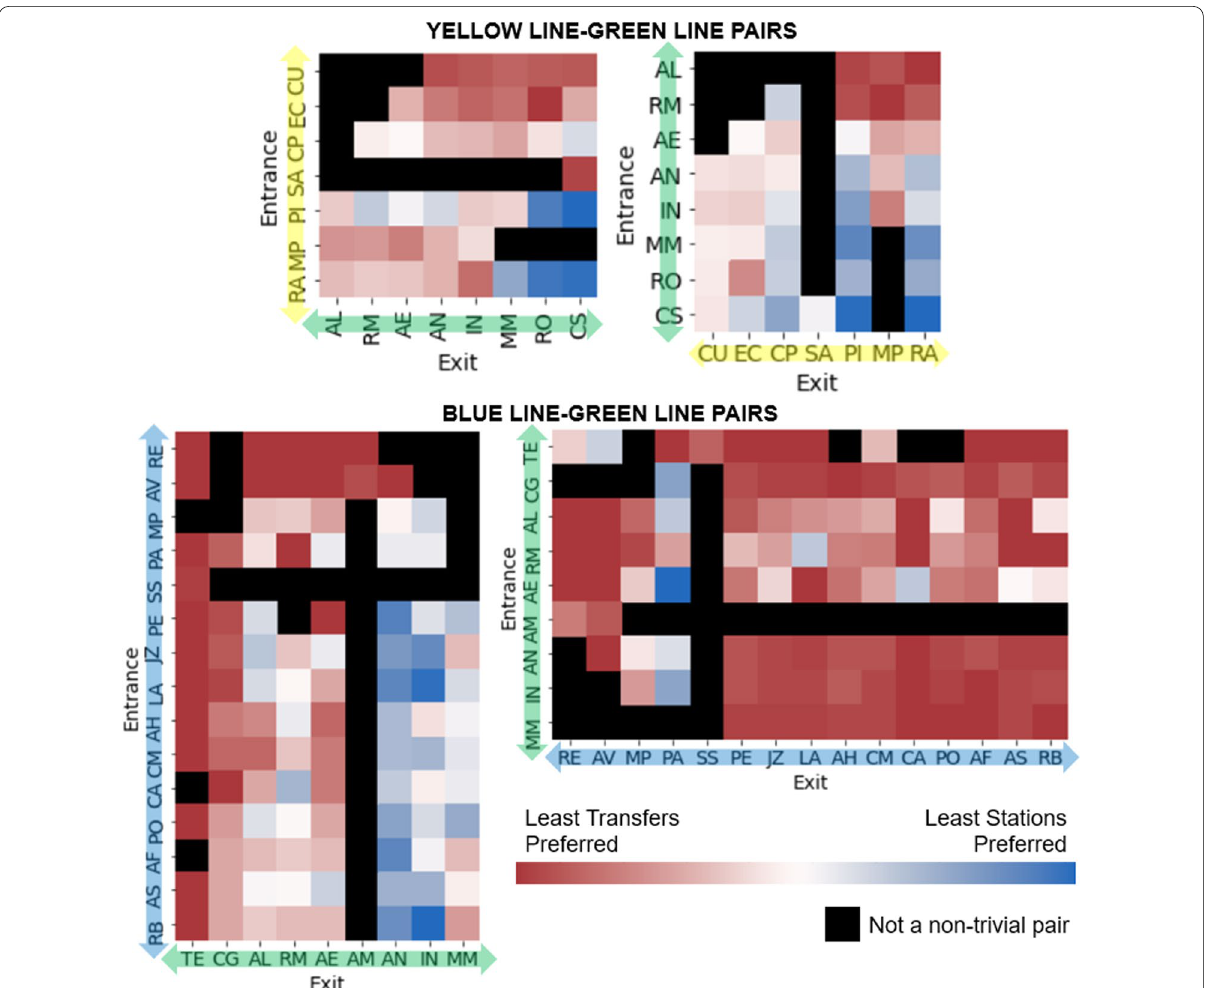
Fig. 11 Route preference for passengers on non‑trivial pairs in the yellow‑green lines and blue‑green lines. For conciseness, rows and columns with no non‑trivial pairs are